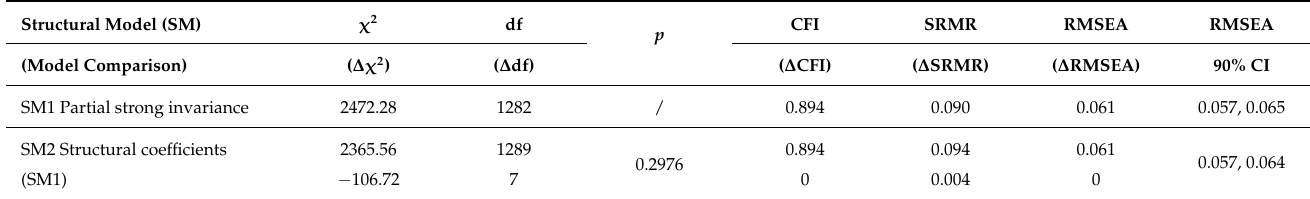
Table 7. Testing measurement invariance of structural coefficients.